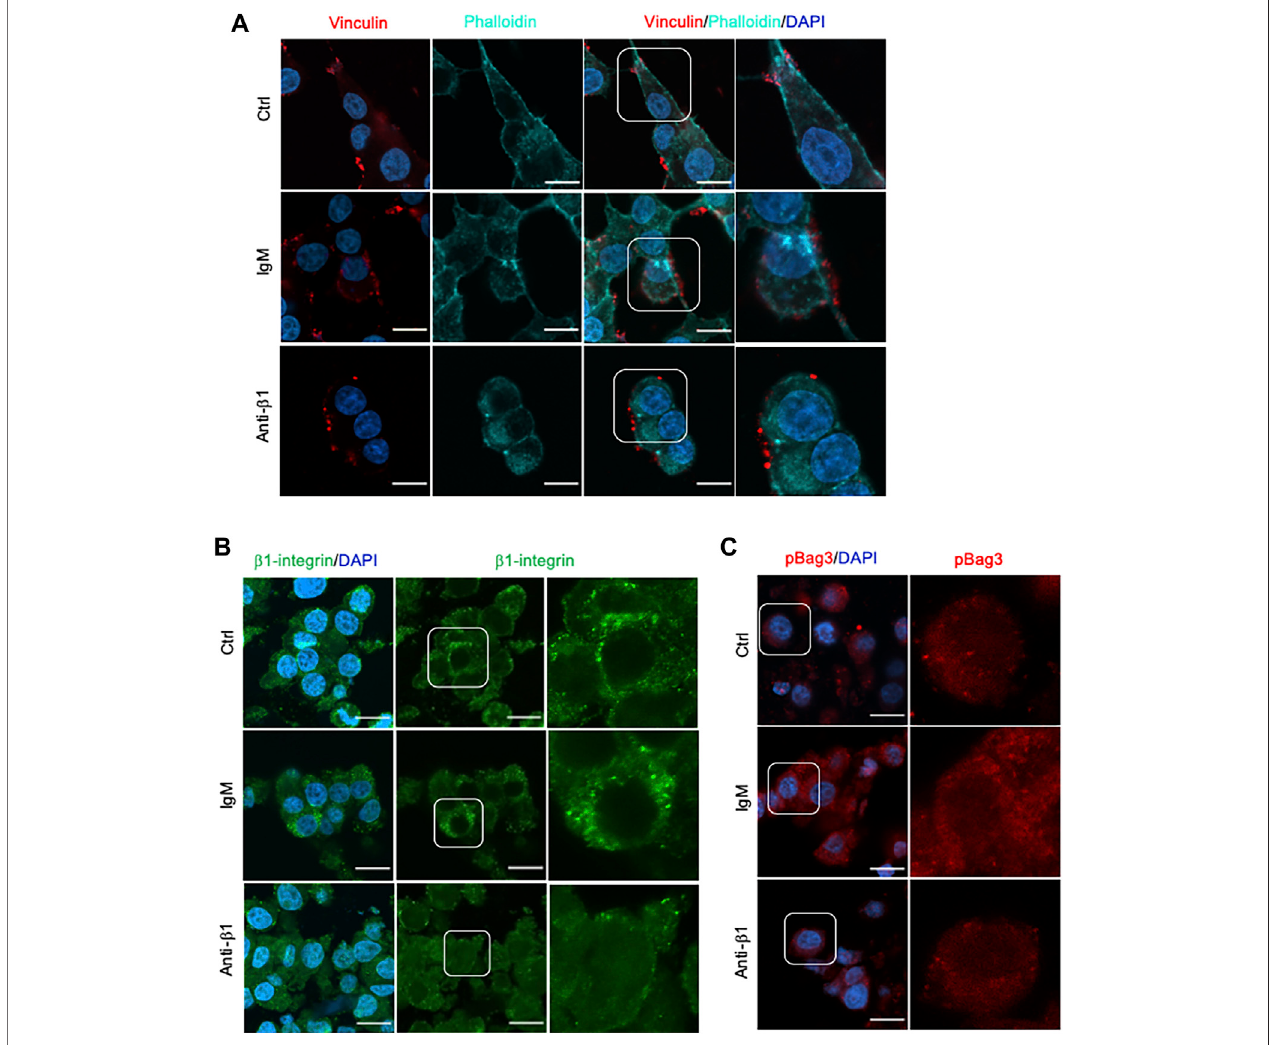
FIGURE 6 | Blocking β 1-integrin diminished focal adhesion, β 1-integrin and BAG3 phosphorylation immuno fl uorescence signals. Representative immunostaining images of (A) vinculin (red) and F-actin (cyan), (B) β 1-integrin (green), and (C) pBAG3 (red) in INS-1 cells treated with anti- β 1, IgM, or untreated control (Ctrl) cultured on collagen IV for 24 hrs. Nuclei are counterstained with DAPI, and magni fi ed images are highlighted. Scale bar: 10 µm.